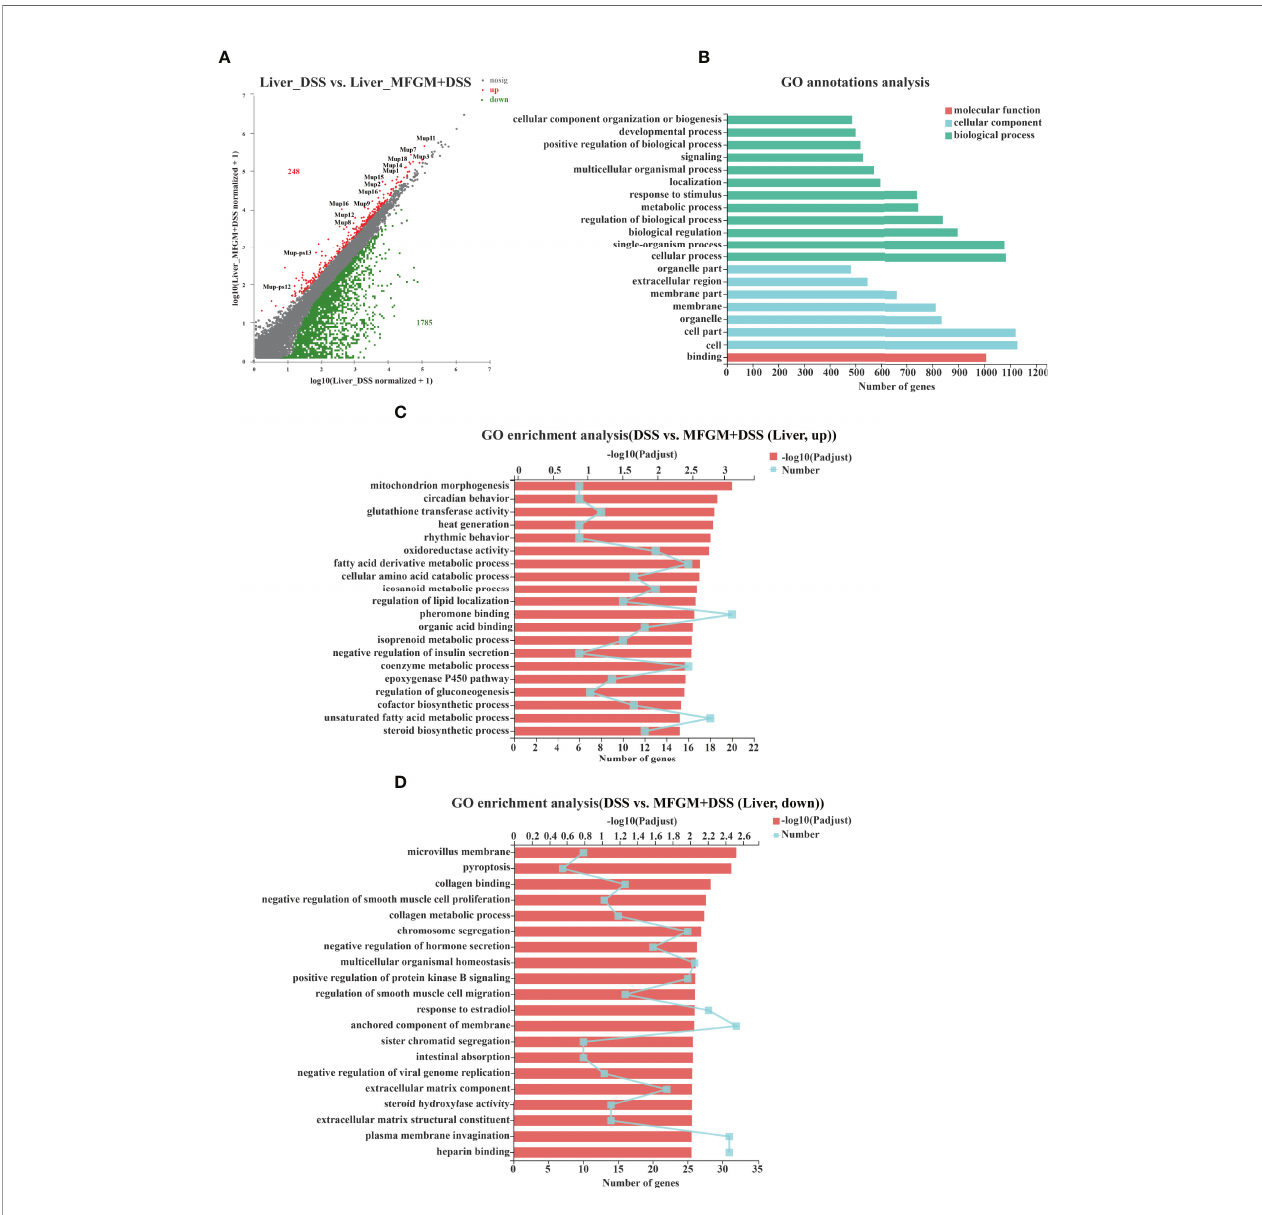
FIGURE 5 | Milk fat globule membrane (MFGM) impacted the gene expression pro fi le of liver in dextran sulfate sodium (DSS)-treated mice. (A) Scatter diagram of the differentially expressed genes in the comparison. The red point denotes an upregulated gene in the MFGM + DSS group, while the green point denotes a downregulated gene in the MFGM + DSS group compared with the DSS group. The gray point denotes an insigni fi cantly expressed gene in the comparison. (B) Gene Ontology (GO) annotation analysis of the differentially expressed genes in the comparison of the liver. GO enrichment of the upregulated genes (C) and the downregulated genes (D) in the comparison of the